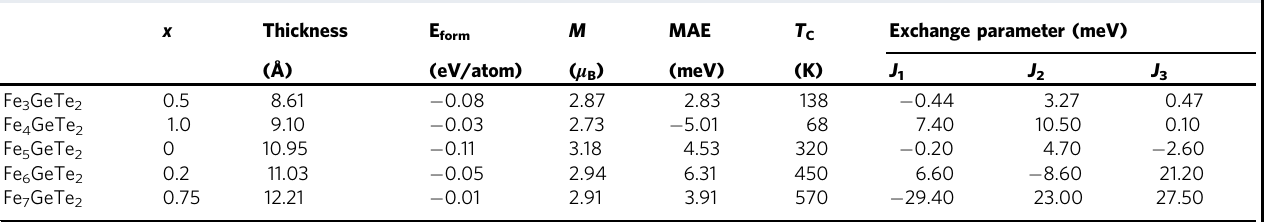
Fe 2 + /Fe 3 + ratio x , effective thickness, formation energy E form , magnetic moment M per Fe atom, magnetic anisotropy energy (MAE) per unit cell, Curie temperature T C , and exchange parameters J 1 , J 2 , and J 3 of Fe n GeTe 2 multilayer fi